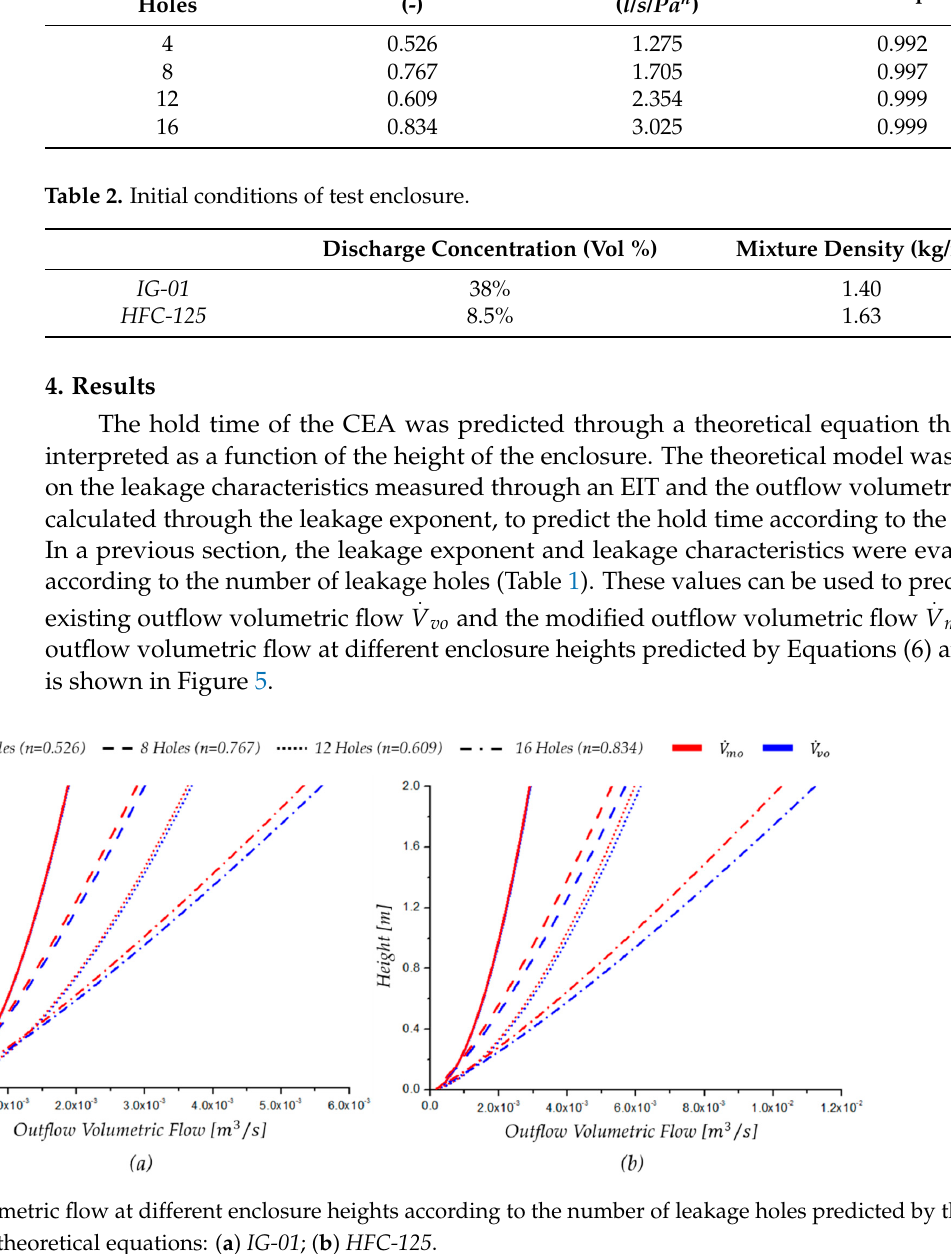
Table 1. Measured leakage exponent and leakage characteristics.